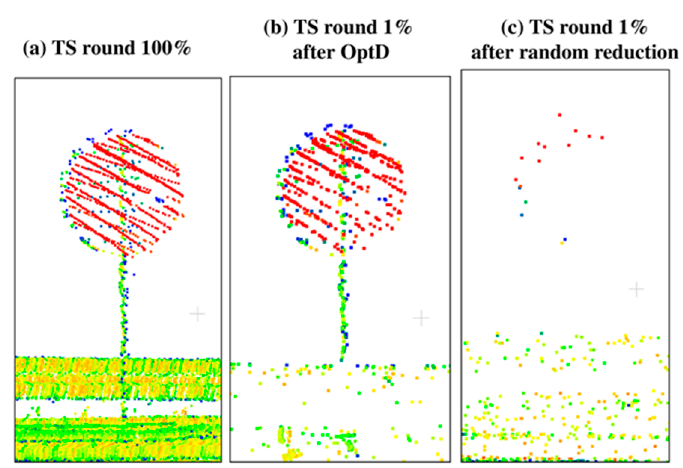
Figure 8. Data reduction effect on a round TS: ( a ) original, ( b ) round TS after OptD method, ( c ) round TS after random reduction. Geosciences 2020 , 10 , x FOR PEER REVIEW